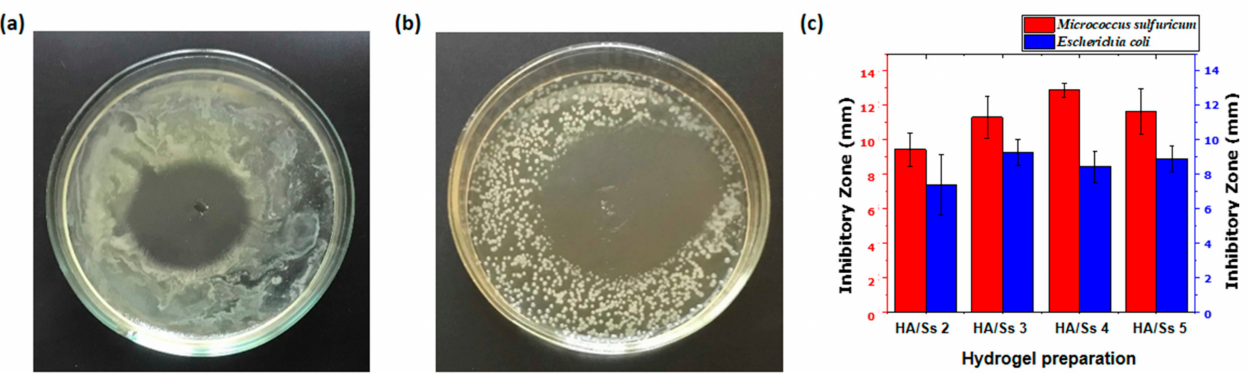
Figure 6. ( a ) Inhibitory band test of hyaluronic acid/spider silk-based hydrogels on gram negative Escherichia coli bacteria. ( b ) Inhibitory band test of hyaluronic acid/spider silk-based hydrogels on gram positive Micrococcus sulfuricum bacteria. ( c ) Inhibitory zone length of hyaluronic acid/spider silk-based hydrogels on gram negative ( Escherichia coli ) and gram positive ( Micrococcus sulfuricum )